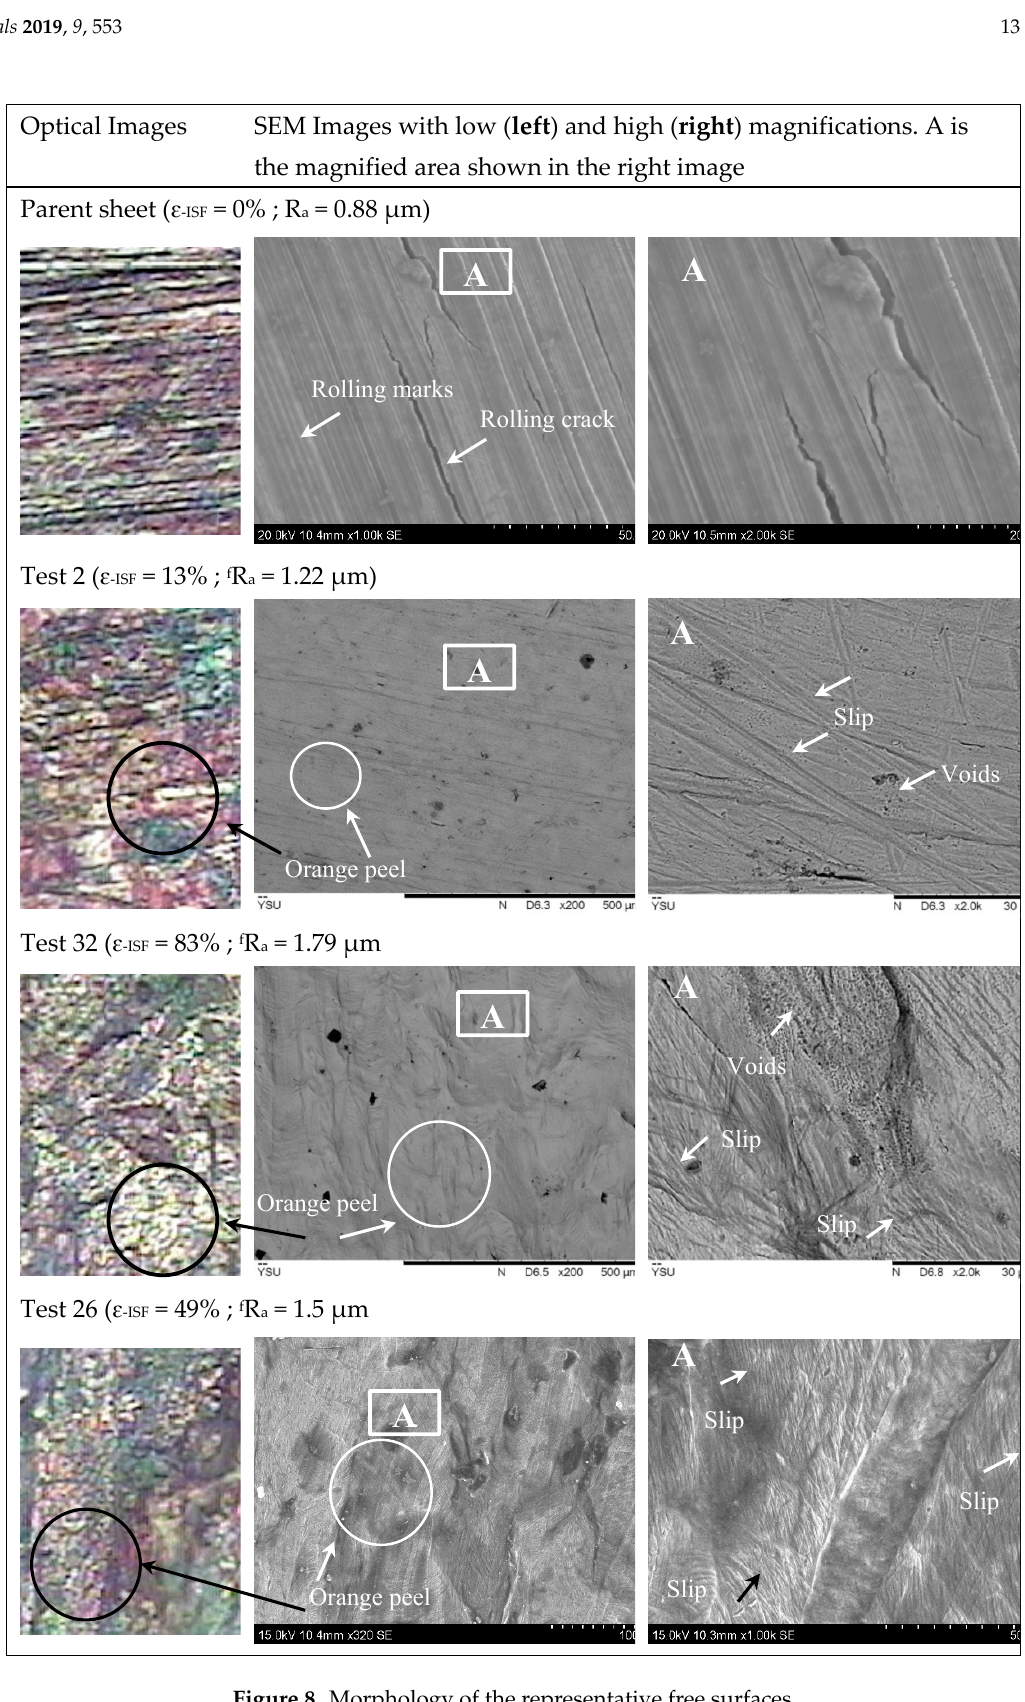
Figure 8. Morphology of the representative free surfaces.